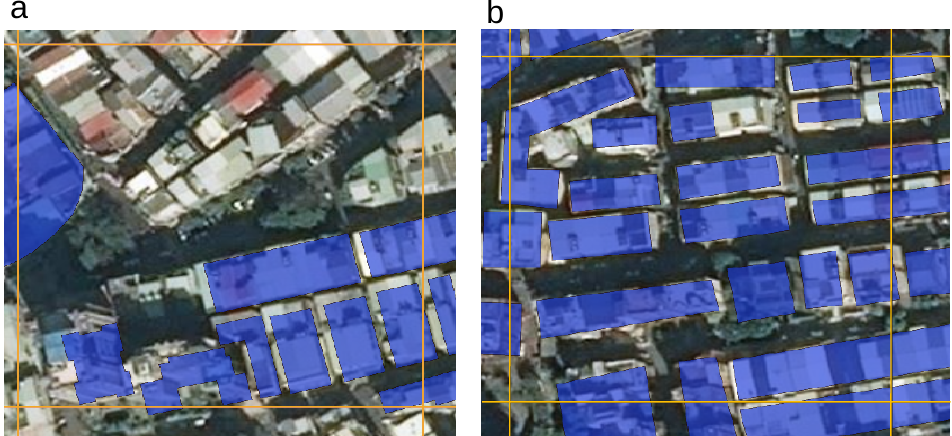
Figure 3. ( a ) Example of a task with low OSM building completeness; ( b ) example of a task with almost complete OSM building